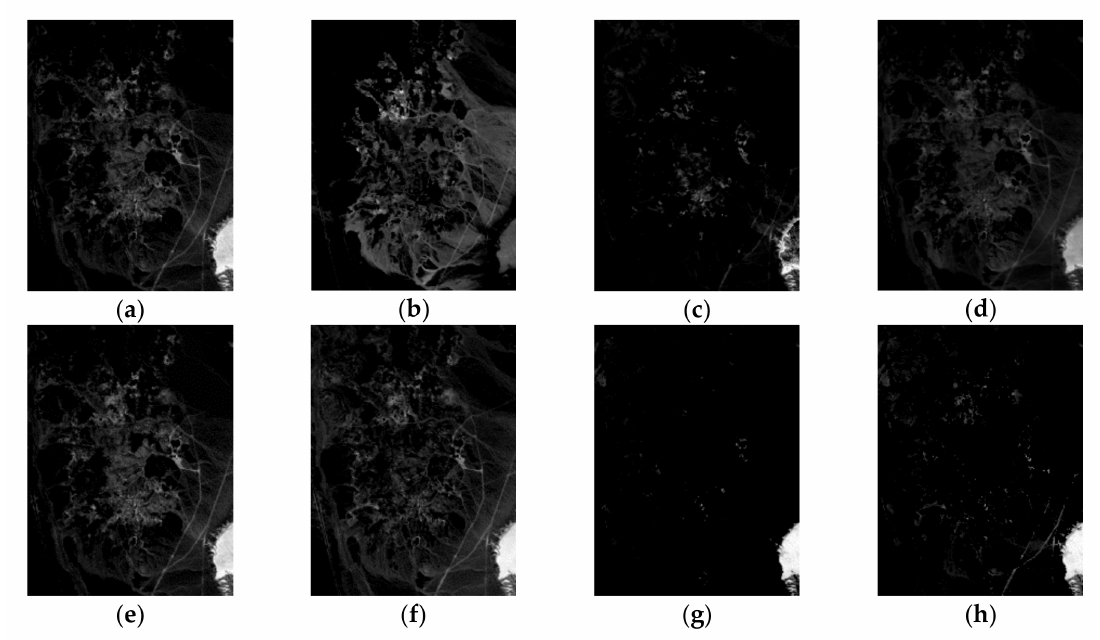
Figure 15. Montmorillonite: ( a ) VCA, ( b ) N-FINDR, ( c ) SGA, ( d ) C-NMF, ( e ) MVC-NMF, ( f ) ICE, ( g ) SPICE, ( h ) SPEEVD.